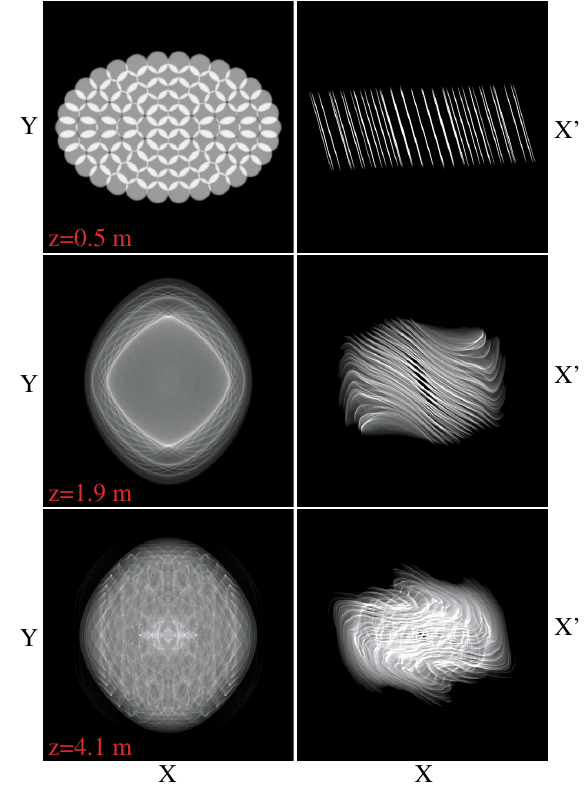
FIG. 4. (Color) Density plots of ( x - y ) and ( x - x 0 ) spaces. In the ( x - x 0 ) plots, the gray scale is brightened. All densities greater than one-quarter of the maximum are drawn in white. From there, the gray scale linearly goes down to zero. The z is the distance from the end of the preaccelerator column.